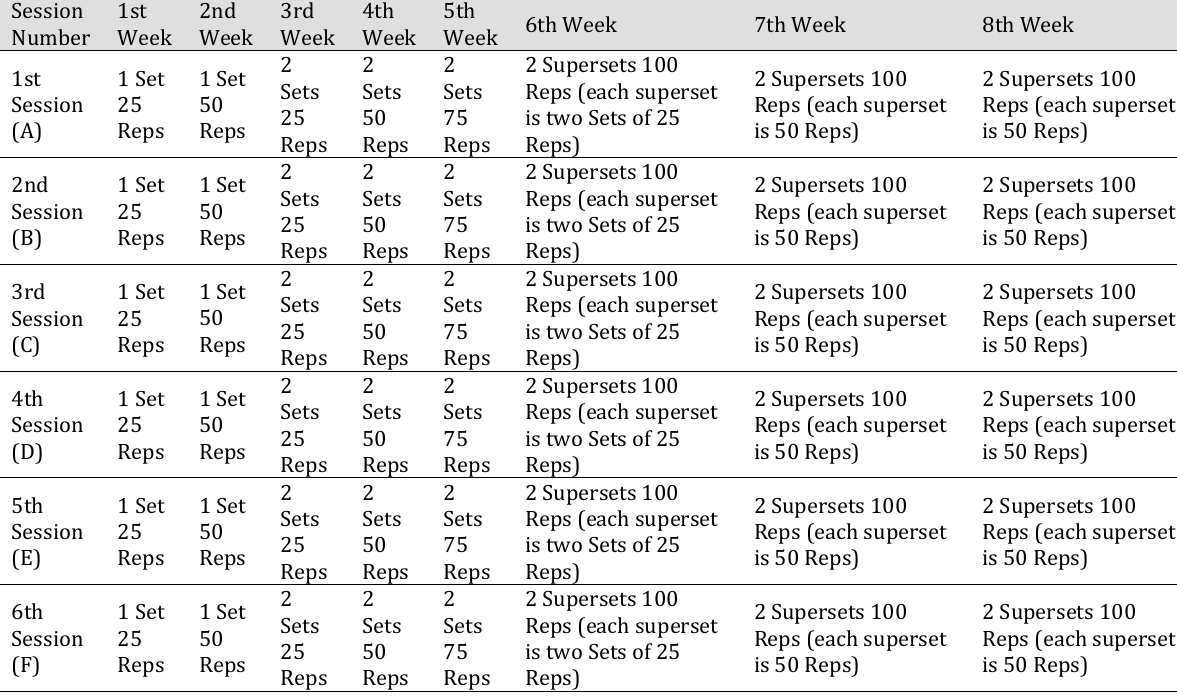
Table 3. Activation protocol throughout the training